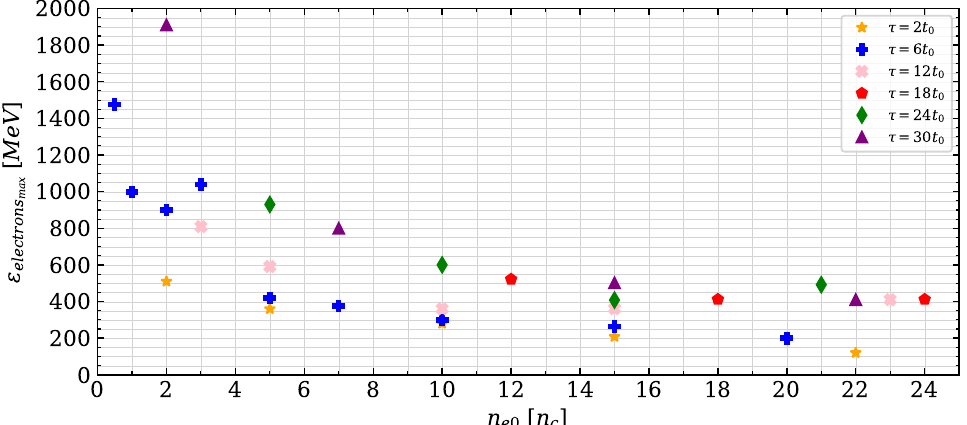
Figure 8. Maximum electron energy at the optimum target thickness vs target density for various laser pulse durations. Target parameters: L y = 30 µ m. Laser parameters: λ = 1 µ m, a 0 = 85 and w 0 = 12.5 µ